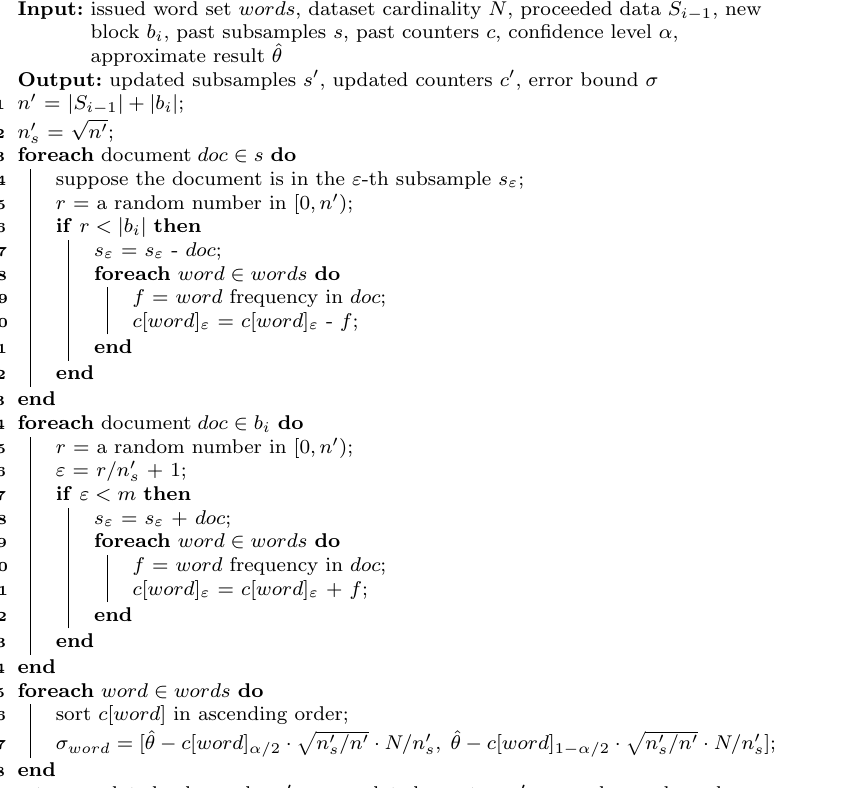
Algorithm 2: Progressive